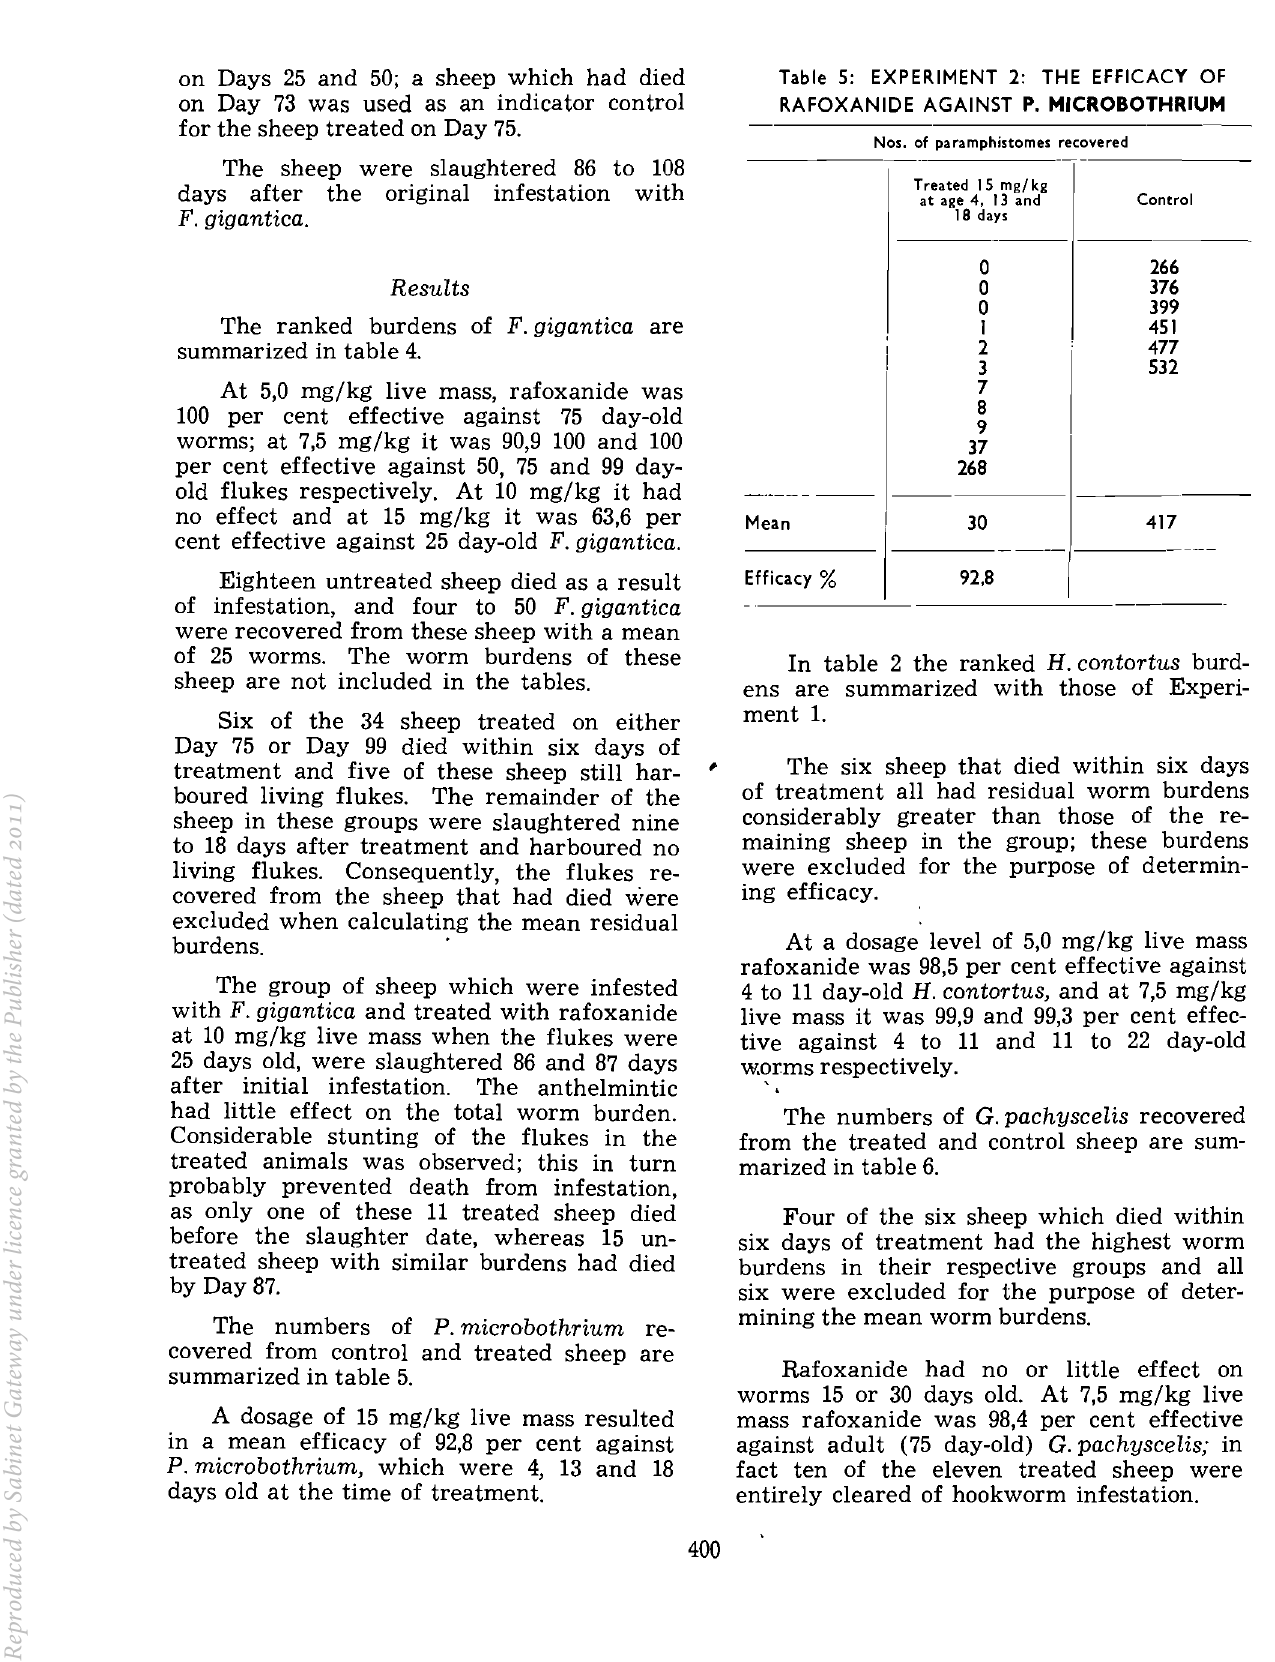
Table 5: EXPERIMENT 2: THE EFFICACY